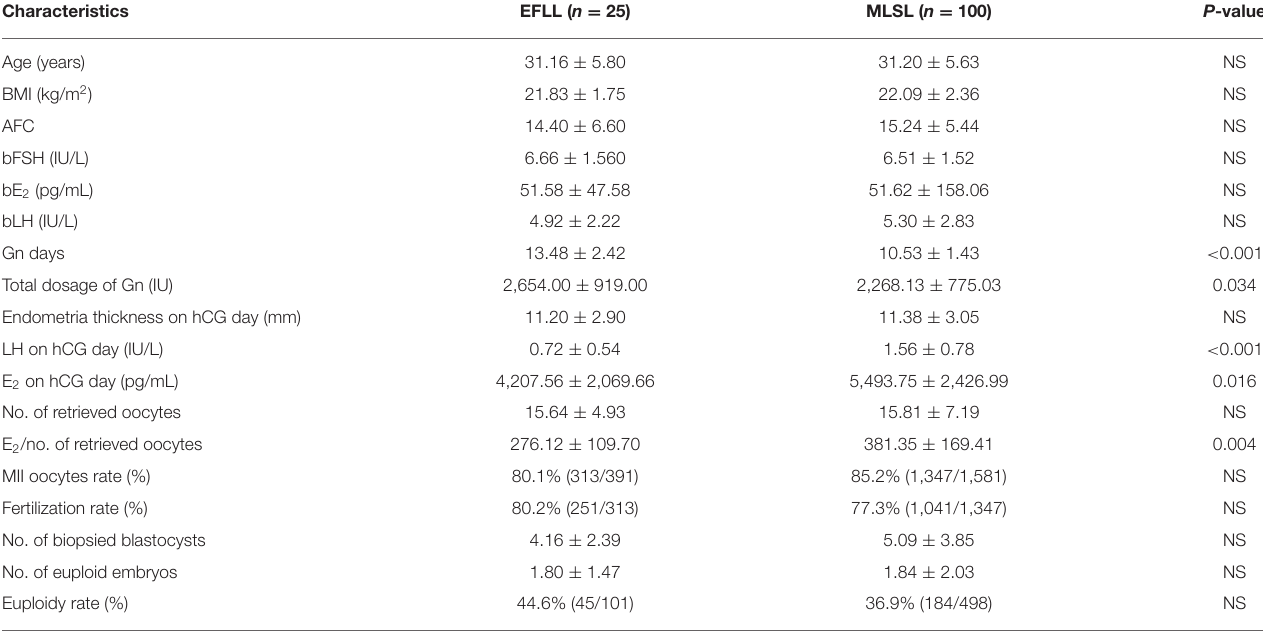
TABLE 1 | Baseline characteristics and outcomes of PGT-A cycle. Characteristics